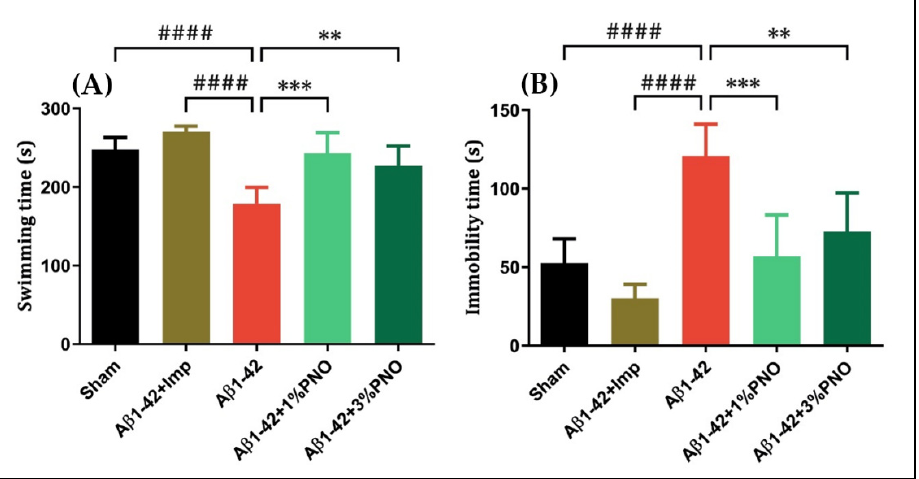
Figure 3. Effects of the inhaled Pinus halepensis essential oil (PNO, 1%, and 3%) on the depressive-like behavior in the forced swimming test (FST) in the A β 1-42-treated rats. Values are means ± S.E.M. ( n = 10). ( A ) A β 1-42 vs. sham: #### p < 0.0001; A β 1-42 vs. A β 1-42 + Imp: #### p < 0.0001; A β 1-42 vs. A β 1-42 + 1% PNO: *** p = 0.0003 and A β 1-42 vs. A β 1-42 + 3% PNO: ** p = 0.0022. ( B ) A β 1-42 vs.